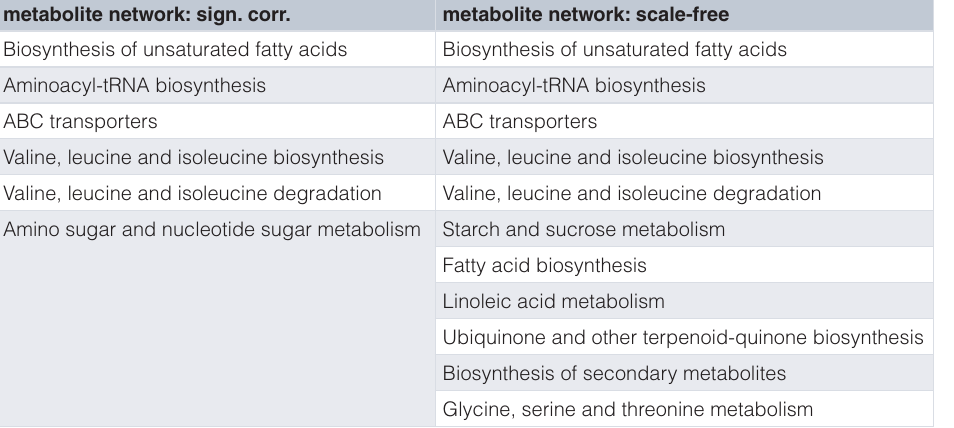
Table 2. Overrepresented KEGG pathways for the SBM-derived blocks of the metabolite networks (reduced by significance of correlation, sign. corr., or by a criterion on scale-freeness, scale-free). metabolite network: sign.